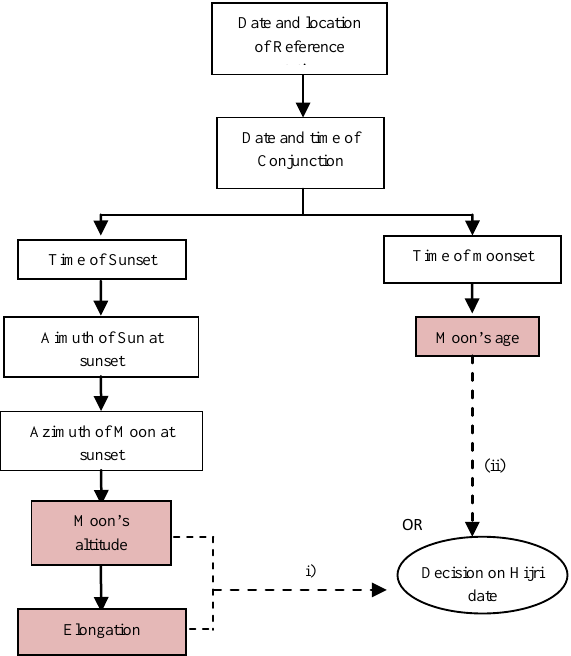
Figure 3. The concept of Hijrah date determination based on Imkanur rukyah criteria